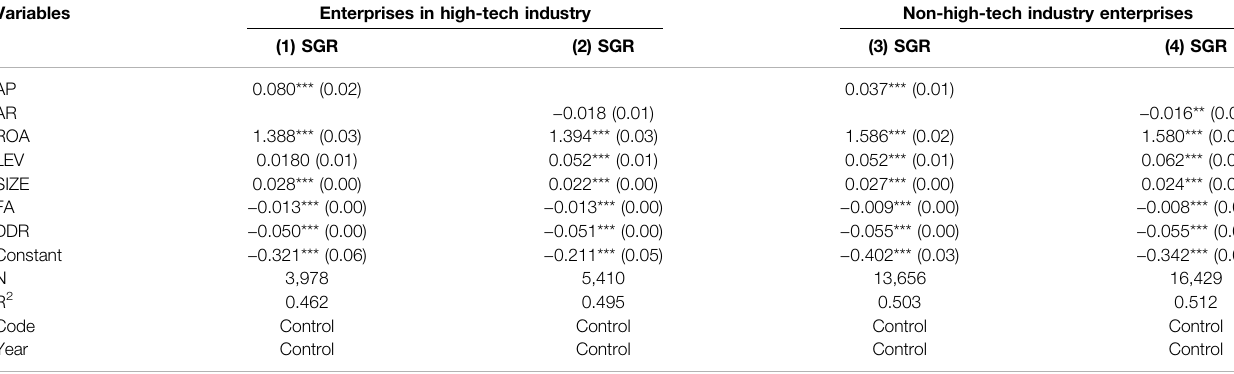
TABLE 6 | Heterogeneity analysis: High-tech and non-high-tech industries. Variables